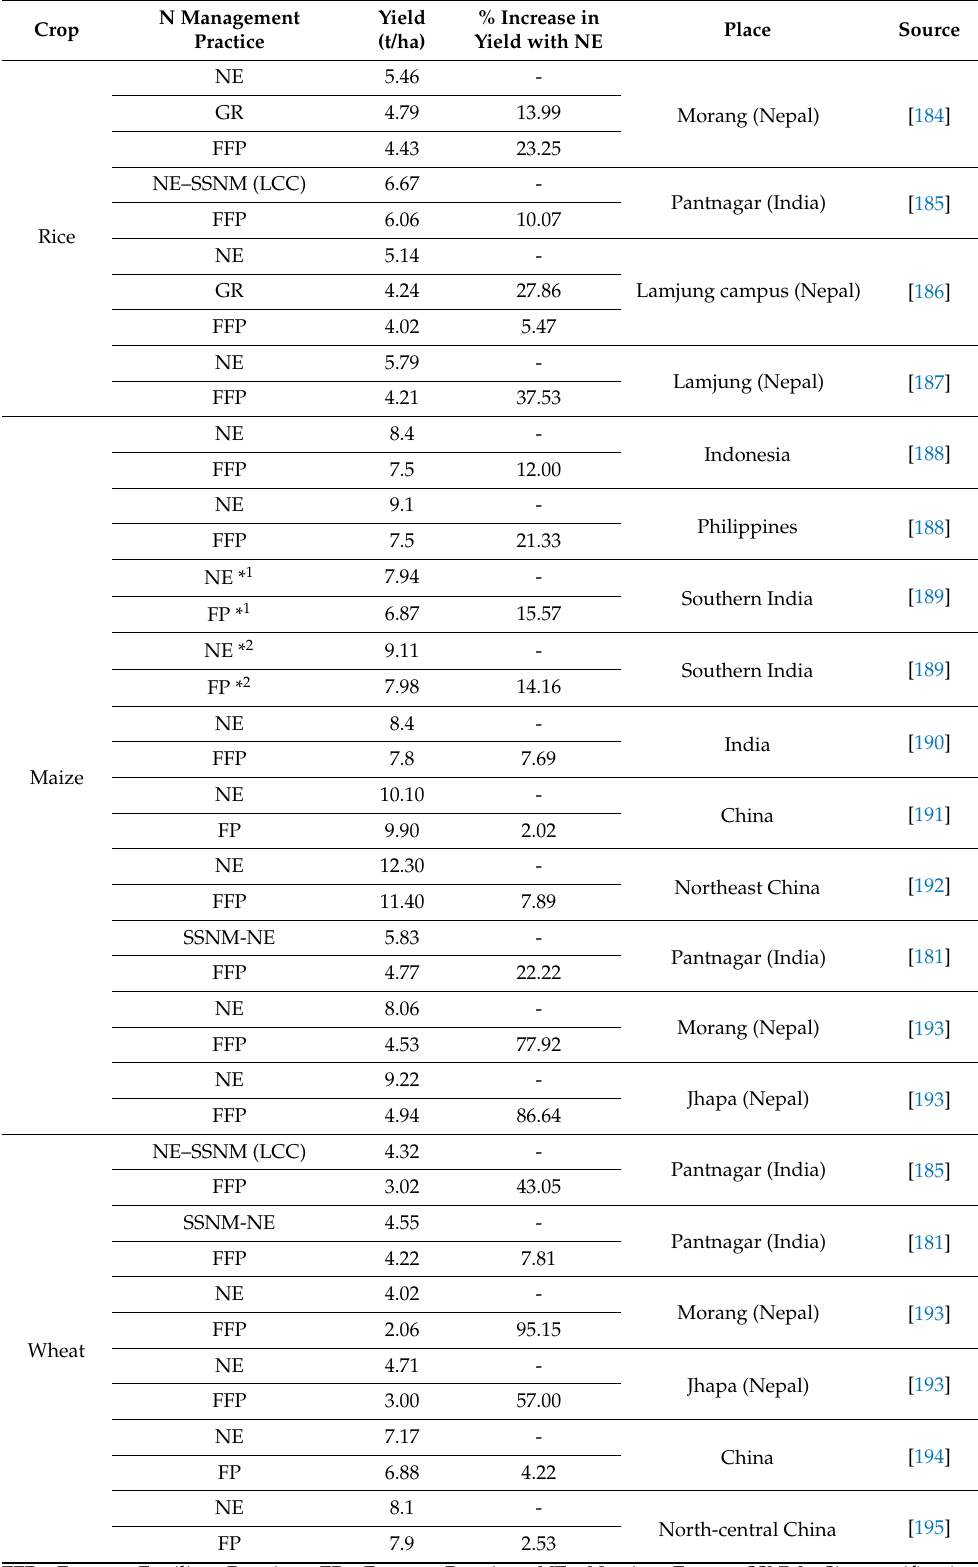
Table 5. Effect of Nutrient Expert (NE)-based N-management practices on grain yield of different cereals.